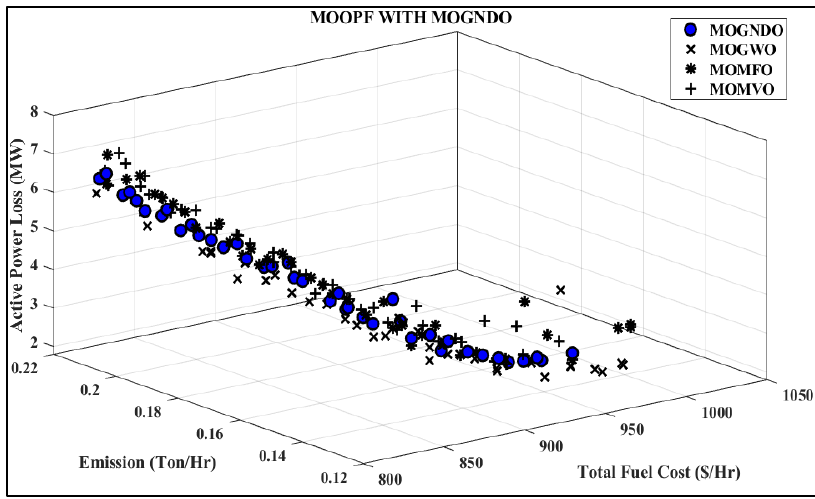
Figure 23. PF of TFC, emission, and APL minimization with different algorithms.